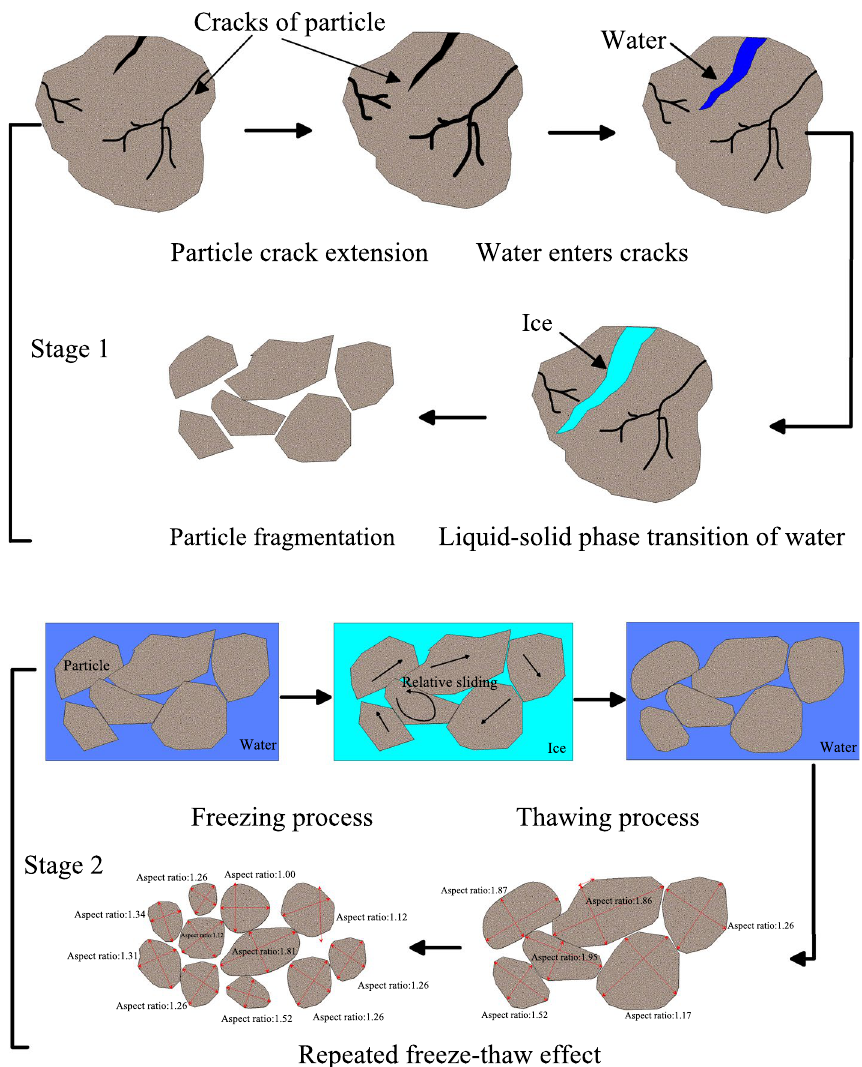
Figure 10. Conceptual diagram of freeze–thaw effect changing particle aspect ratio and roundness (Note that the diagram applies to large particle